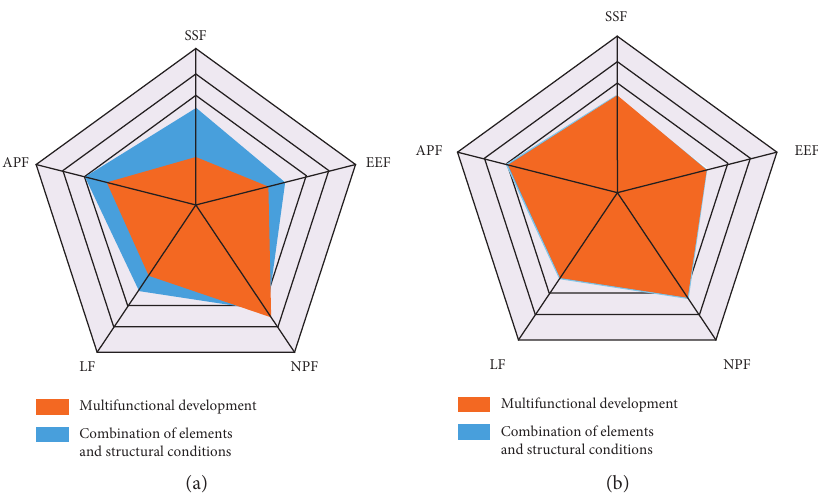
Figure 2: Balanced development of rural multifunction: (a) imbalanced development and (b) balanced